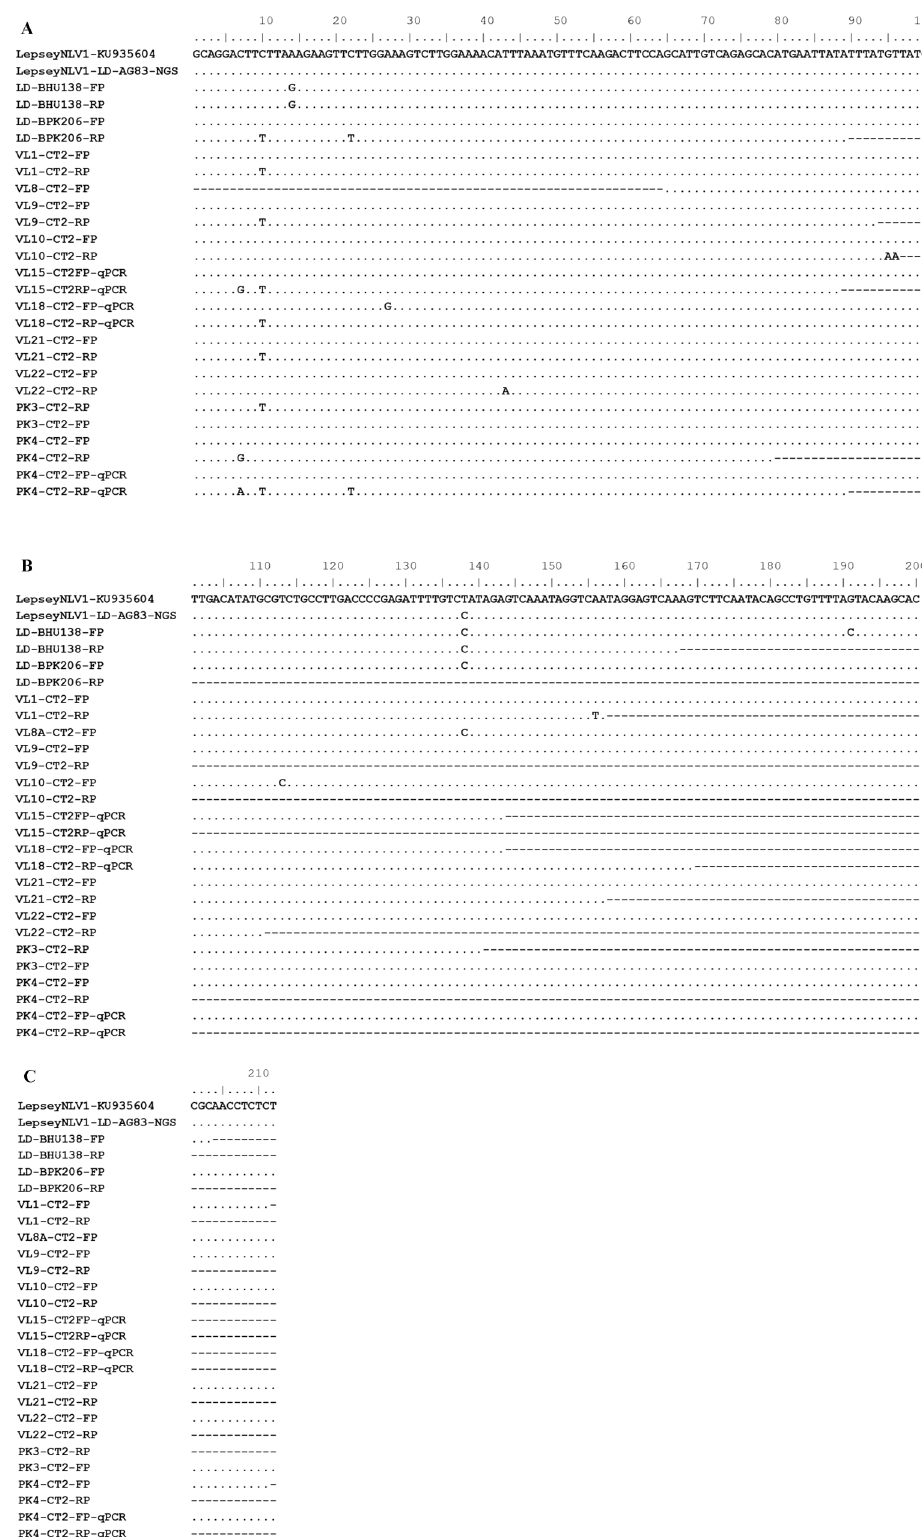
Figure 1. Representative L gene alignment (partial) of the Lepsey NLV1 detected in LD clinical samples. Partial segment L gene sequences of the Lepsey NLV1-positive LD samples and the Lepsey NLV1 isolate SBSS1 (obtained from AG83 by NGS sequencing; accession number KY628363) were aligned together with the only other Lepsey NLV1 sequence available in GenBank (accession number KU935604). The numbering of the nt positions corresponds to nt positions 167–378 of the Lepsey NLV1 sequence with accession number KU935604. FP and RP represent sequences obtained using relevant forward and reverse primers, respectively. “qPCR” suffix denotes that bidirectional sequencing was attempted on purified qPCR products. In the alignment, second to sixth sequences were from previously published virus-positive LD laboratory isolates 8